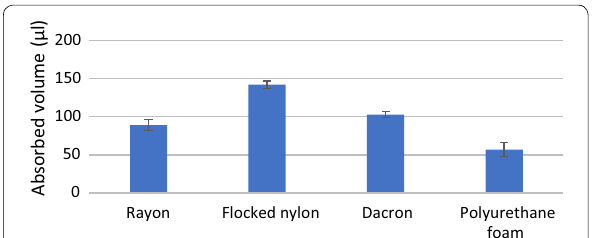
Fig. 2 The volume of water absorbed by investigated types of